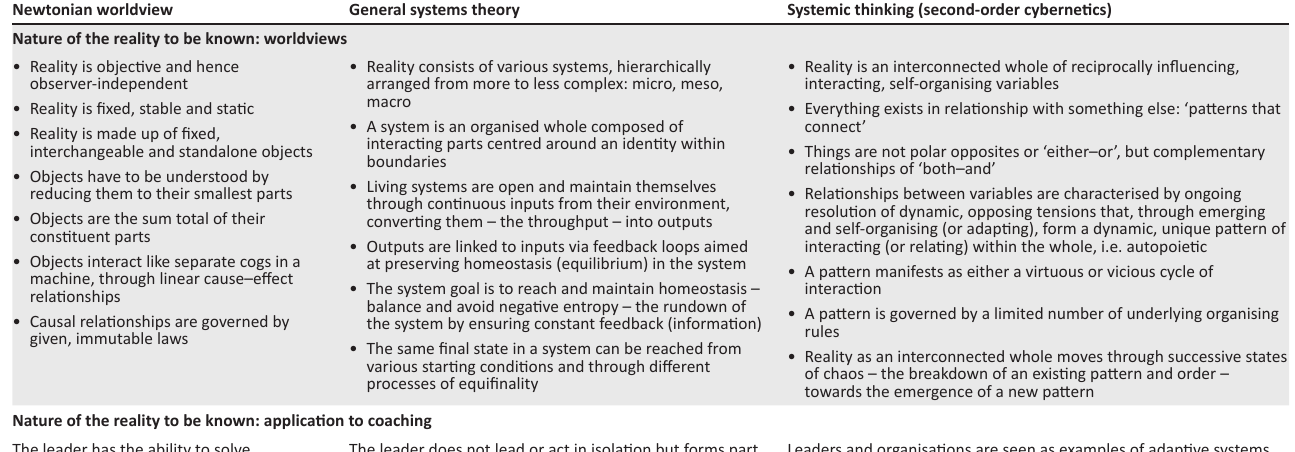
TABLE 2: Nature of the reality to be known: worldviews with their application to coaching. Newtonian